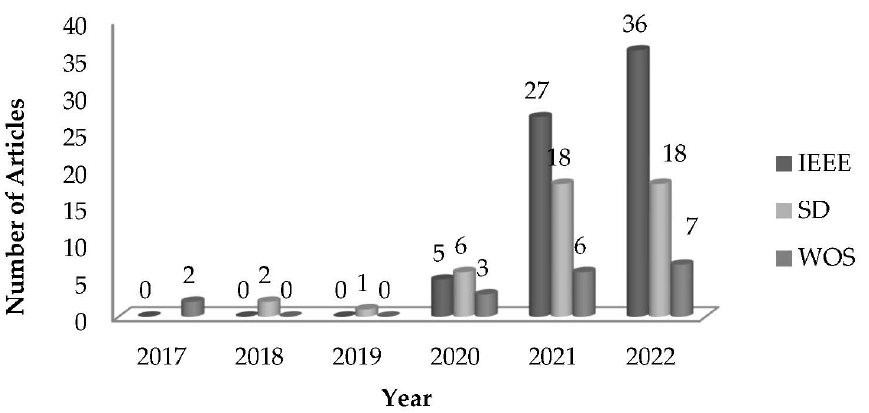
Figure 3. Number of articles published since 2017 related to this scope of study.